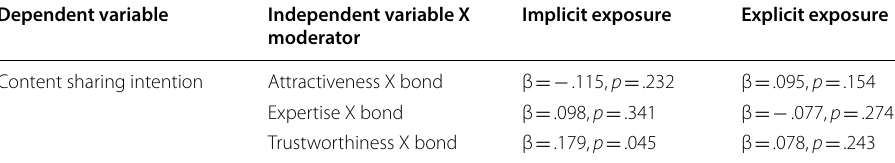
Table 14 Moderated regression analysis result of emotional bond on relationship between vloggers’ attributes and content sharing intention depending on product exposure